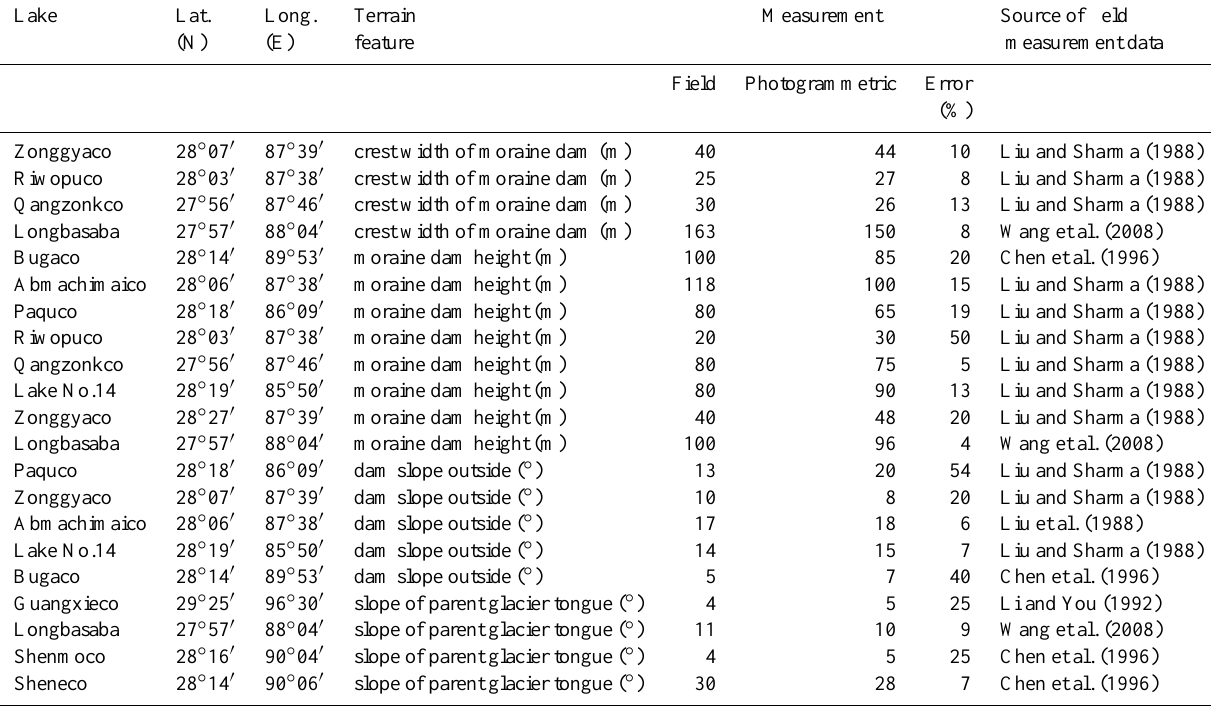
Table 6. Comparison of aerial photogrammetric measurements with field-based measurements. Lake Lat. Long. Terrain Measurement feature measurement data Field